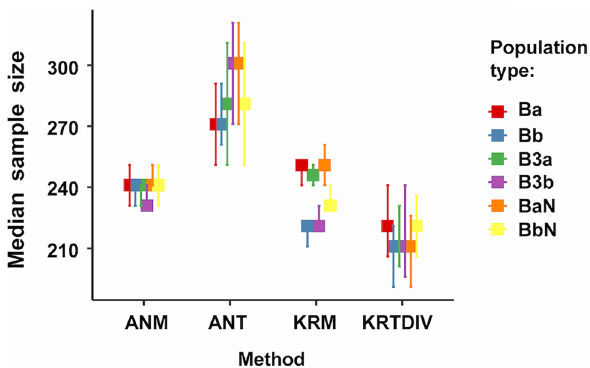
Figure 1. Simulation run_three: population group means: G1: 100; G2: 100-1; G3: 100-2; population variance: 20. Medians of measured (ANM: ANOVA, KRM: Kruskal-Wallis) and Monte-Carlo predicted (ANT: ANOVA, KRTDIV: Kruskal-Wallis) sample sizes for 80% power. Error bars: 95% confidence intervals. For run settings, algorithms and Population type definitions, see Tables 1 and